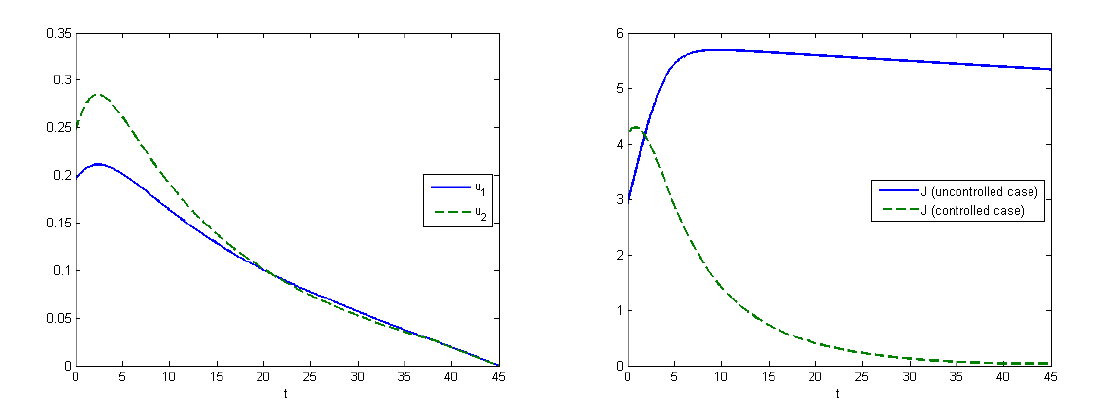
Figure 5. Experiment 2. Left : Optimal control in the SIR model with virus mutation and convex cost functions h i ( u i ) . Vertical axis shows the amount of applied control. Right : Comparison of aggregated costs of the SIR model with virus mutation (Controlled model J = 294.59, uncontrolled model J = 1048.5). Vertical axis shows the aggregated costs at time moment t in